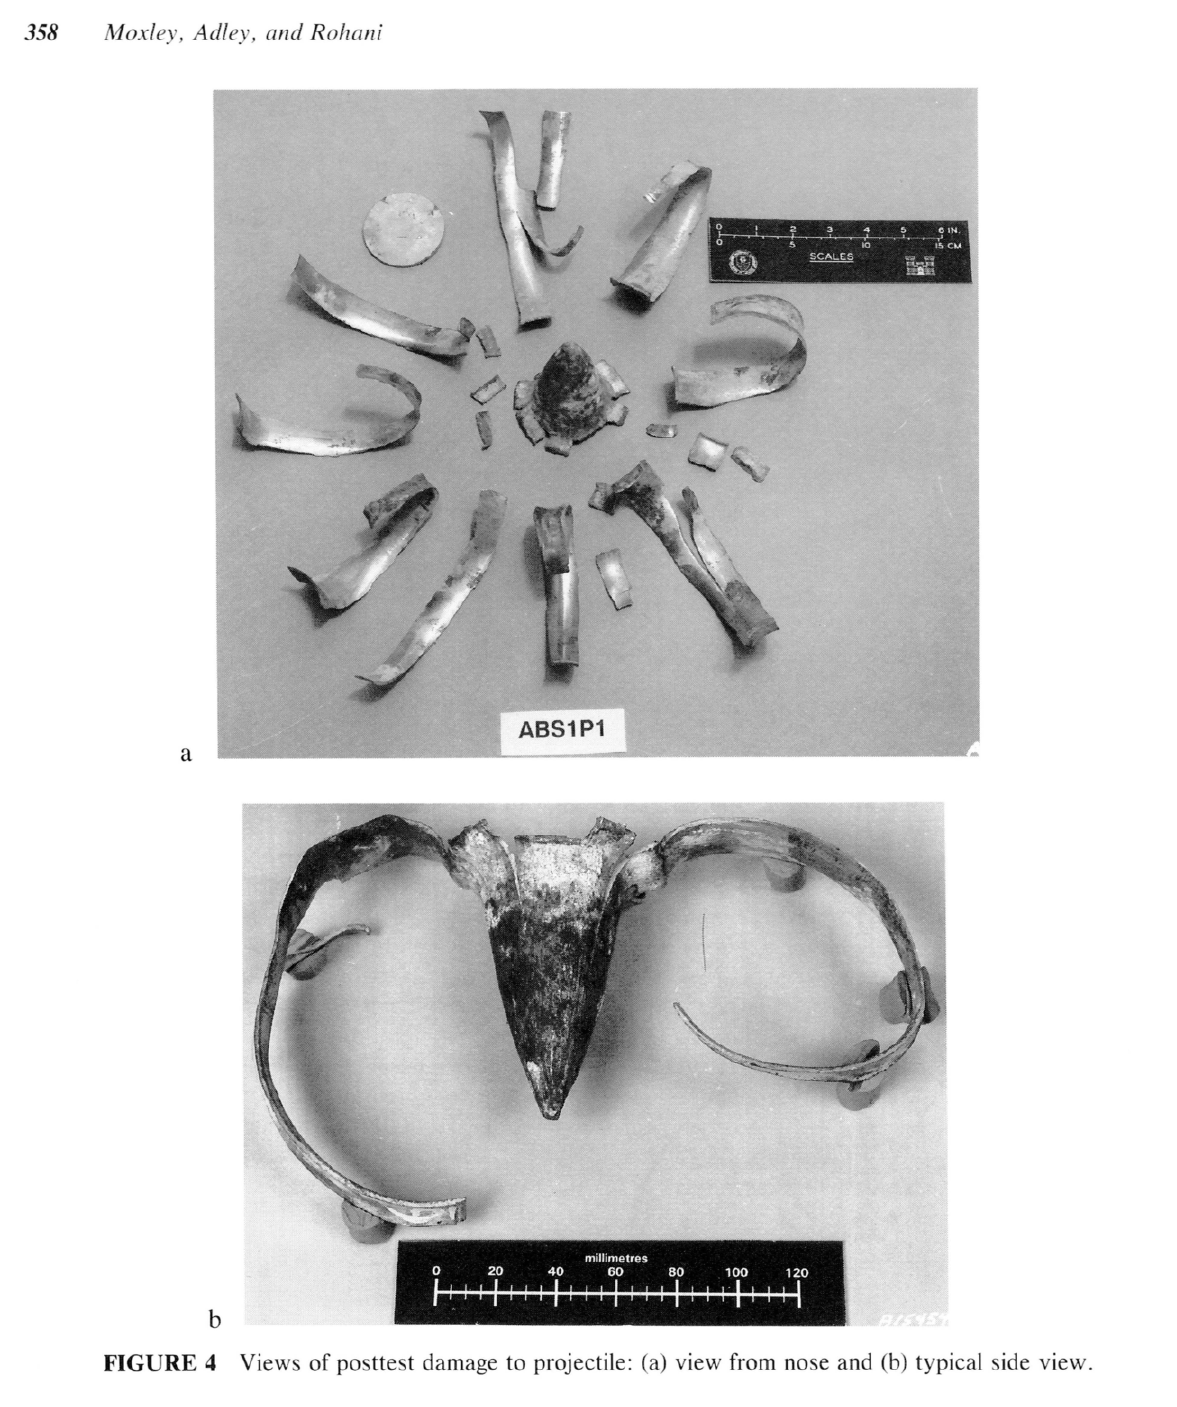
FIGURE 4 Views of posttest damage to projectile: (a) view from nose and (b) typical side